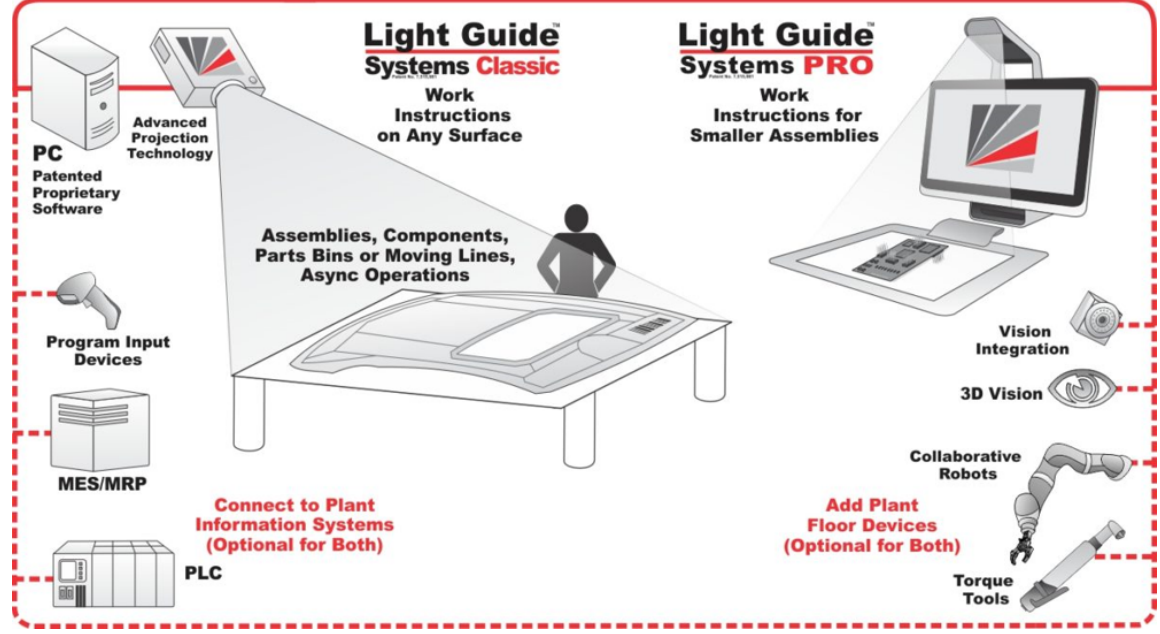
Figure 3: Principle of the method of video-mapping within storage logistics